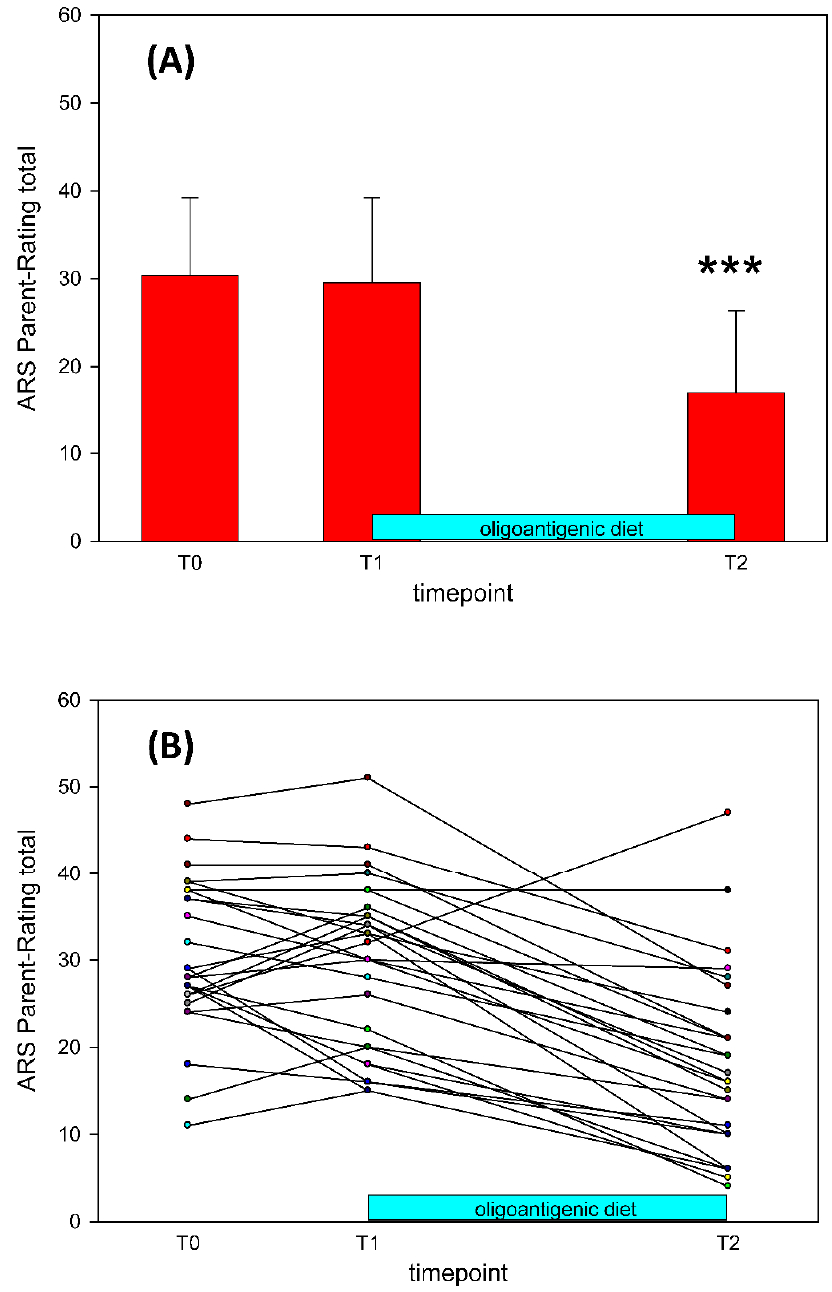
Figure 2. ( A ) Average changes in all participants ( n = 28) of the ARS scores at each time point (means ± SD), p < 0.001 *** (ANOVA with repeated measurements). ( B ) ADHD Rating Scale total scale for all participants in the study. n = 28, T0: Baseline, T1: Start of the OD, T2: End of the